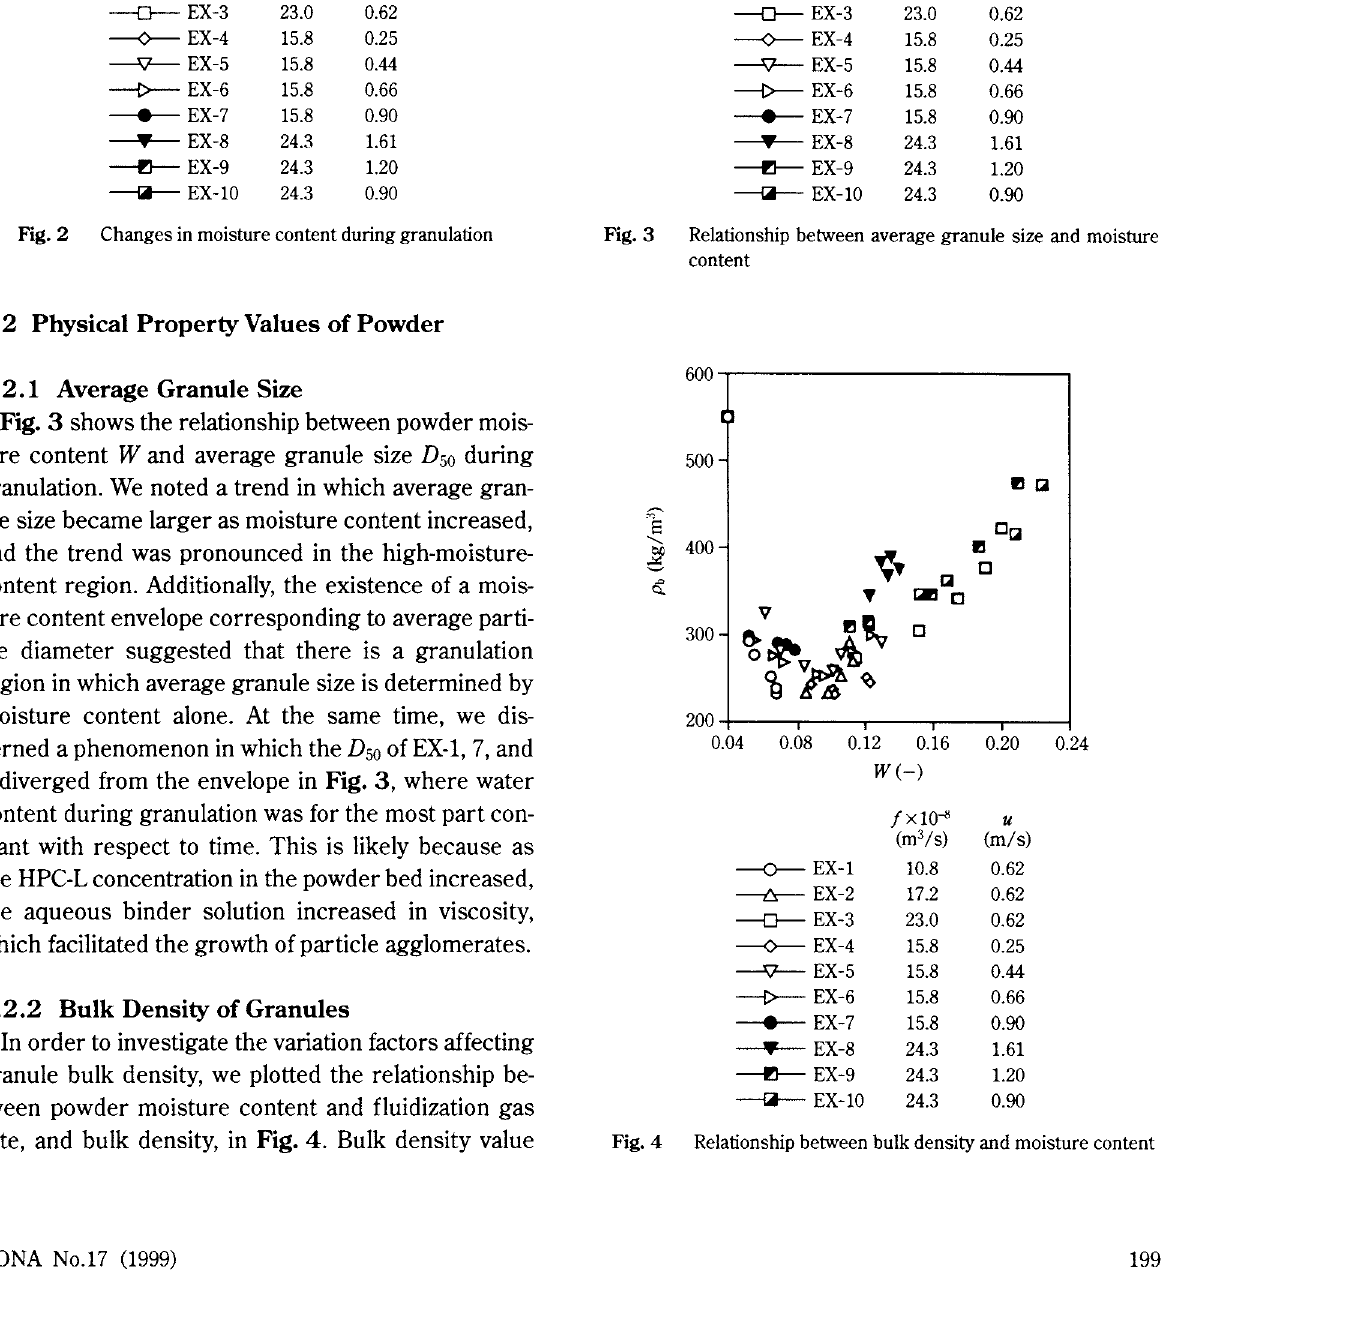
Fig.2 Changes in moisture content during